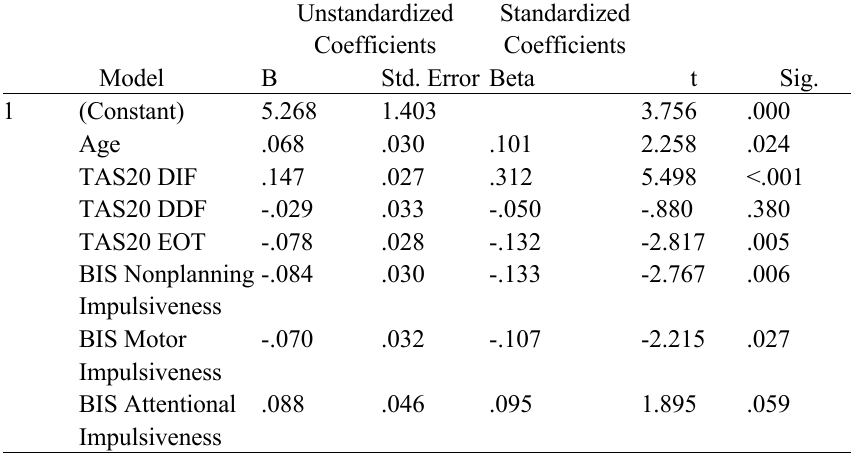
Table 5. Coefficients a of Multiple Regression Analysis with TAS20 and BIS Second- Order